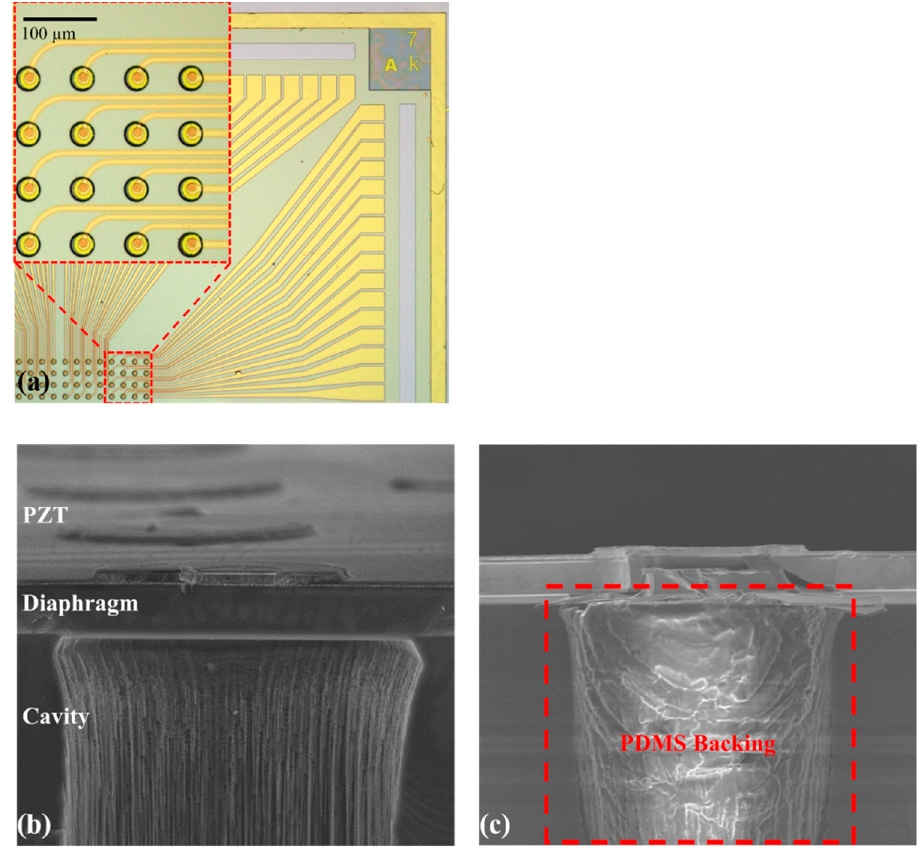
Figure 3. Microscopy pictures of B-PMUTs. ( a ) Top view of a part of 16 × 8 PMUTs arrays. ( b ) Cross-sectional SEM image of a typical element without PDMS backing. ( c ) Cross-sectional SEM image of the element with PDMS filling.